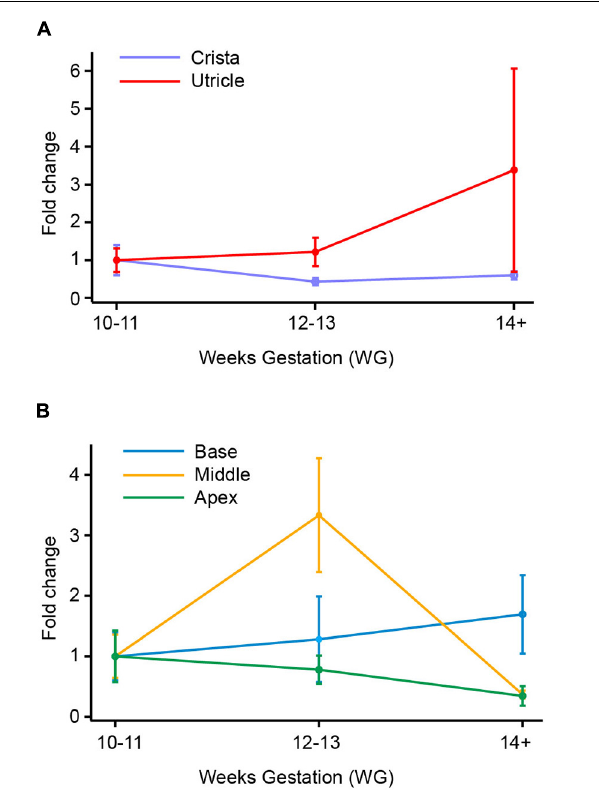
FIGURE 2 | SCN8A (Nav1.6) mRNA in vestibular organs and cochlea. (A) Both crista and utricle exhibit an increase in SCN8A mRNA expression with age. At the ages examined there was a peak in fold change at 14+ WG in both crista (1.8-fold) and utricle (3.7-fold). (B) There were smaller fold changes in the cochlea compared to vestibular organs. The base and apex of the cochlea show decreases in SCN8A expression at 12–13 WG compared to 10–11 WG. At 14+ WG both base and apex then have increases in mRNA expression, greater than that at 10–11 WG and 12–13 WG. The increase in SCN8A mRNA expression in the base of the cochlea was significantly greater at 14+ WG than at 12–13 WG. In contrast to the base and apex, the middle turn of the cochlea had a slight increase in mRNA expression at 12–13 WG compared to 10–11 WG, which plateaued at 14+ WG.